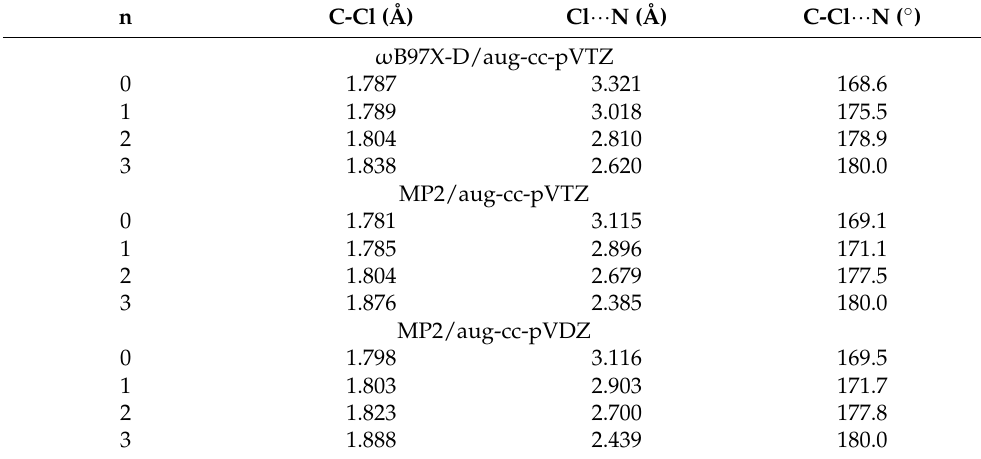
Table 2. Optimized geometries for the CH 3 − n (CN) n Cl ··· NMe 3 complexes; C-Cl bond lengths, Cl ··· N distances and C-Cl ··· N angles are given.